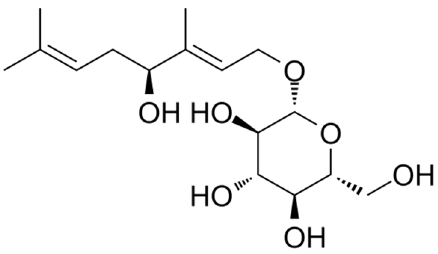
Figure 1. Molecular structure of rosiridin.